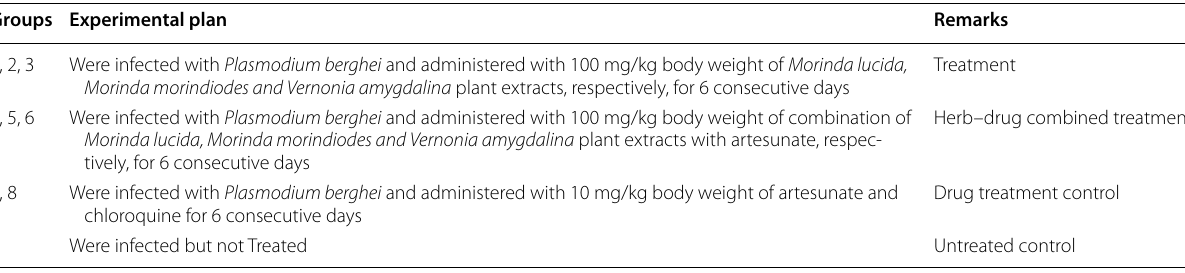
Table 1 Experimental plans for test animals and control Groups Experimental